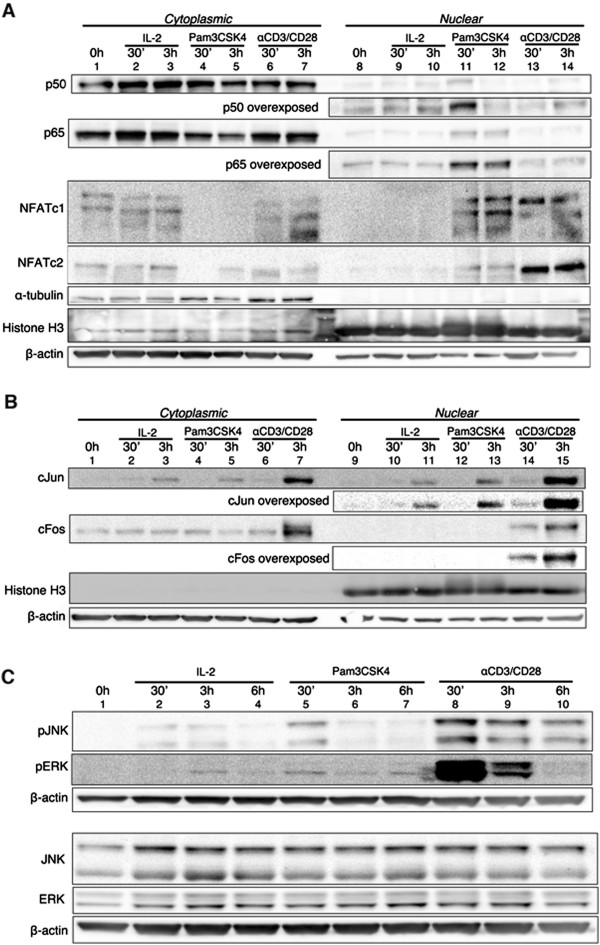
Signaling triggered by Pam3CSK4 in cultured TCM. Culture TCM were either left unstimulated (0 h) or stimulated with IL-2, Pam3CSK4 and αCD3/αCD28 after 30 minutes or 3 hours. Nuclear and cytoplasmic fractions were isolated as indicated in the experimental procedure section. Proteins were loaded on a SDS-polyacrylamide gel, transferred to a membrane and western-blotted against p50, p65, NFATc1, NFATc2, α-tubulin, histone H3 and β-actin (A) or against cJun, cFos, histone H3 and β-actin (B). Data is representative of two donors. (C) Culture TCM were left unstimulated (0 h) or stimulated with IL-2, Pam3CSK4 and αCD3/αCD28 after 30 minutes or 3 hours. Whole cell extracts were isolated as indicated in the experimental procedure section. Proteins were loaded on a SDS-polyacrylamide gel, transferred to a membrane and western-blotted against JNK, phospho-JNK, ERK, phospho-ERK and β-actin. Data is representative of two donors.